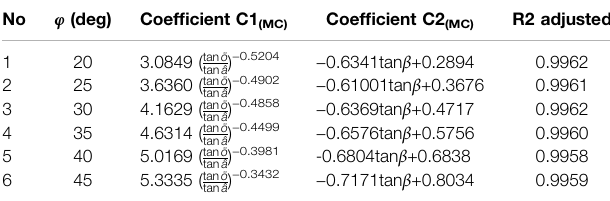
TABLE 3 | Equations of C1 (MC) and C2 (MC) (slope angle β < 45 ° ).